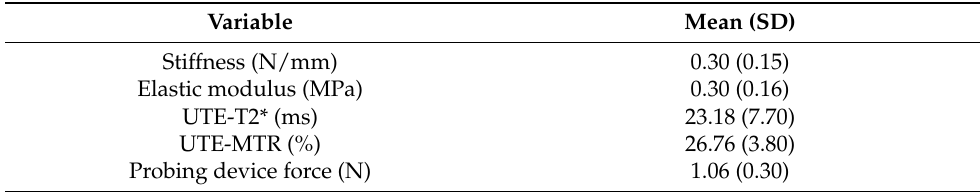
Table 1. Descriptive statistics for outcome and predictor variables ( N = 93).